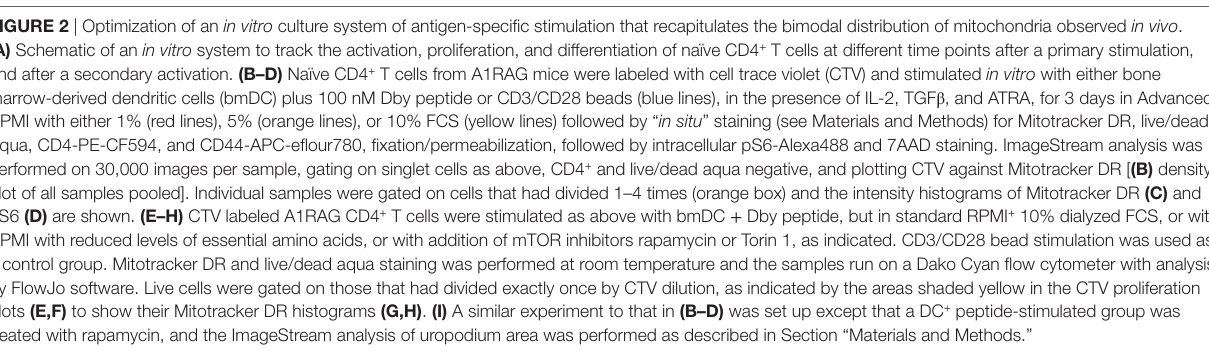
FigUre 2 | Optimization of an in vitro culture system of antigen-specific stimulation that recapitulates the bimodal distribution of mitochondria observed in vivo . (a) Schematic of an in vitro system to track the activation, proliferation, and differentiation of naïve CD4 + T cells at different time points after a primary stimulation, and after a secondary activation. (b–D) Naïve CD4 + T cells from A1RAG mice were labeled with cell trace violet (CTV) and stimulated in vitro with either bone marrow-derived dendritic cells (bmDC) plus 100 nM Dby peptide or CD3/CD28 beads (blue lines), in the presence of IL-2, TGF β , and ATRA, for 3 days in Advanced RPMI with either 1% (red lines), 5% (orange lines), or 10% FCS (yellow lines) followed by “ in situ ” staining (see Materials and Methods) for Mitotracker DR, live/dead Aqua, CD4-PE-CF594, and CD44-APC-eflour780, fixation/permeabilization, followed by intracellular pS6-Alexa488 and 7AAD staining. ImageStream analysis was performed on 30,000 images per sample, gating on singlet cells as above, CD4 + and live/dead aqua negative, and plotting CTV against Mitotracker DR [ (b) density plot of all samples pooled]. Individual samples were gated on cells that had divided 1–4 times (orange box) and the intensity histograms of Mitotracker DR (c) and pS6 (D) are shown. (e–h) CTV labeled A1RAG CD4 + T cells were stimulated as above with bmDC + Dby peptide, but in standard RPMI + 10% dialyzed FCS, or with RPMI with reduced levels of essential amino acids, or with addition of mTOR inhibitors rapamycin or Torin 1, as indicated. CD3/CD28 bead stimulation was used as a control group. Mitotracker DR and live/dead aqua staining was performed at room temperature and the samples run on a Dako Cyan flow cytometer with analysis by FlowJo software. Live cells were gated on those that had divided exactly once by CTV dilution, as indicated by the areas shaded yellow in the CTV proliferation plots (e,F) to show their Mitotracker DR histograms (g,h) . (i) A similar experiment to that in (b–D) was set up except that a DC + peptide-stimulated group was treated with rapamycin, and the ImageStream analysis of uropodium area was performed as described in Section “Materials and